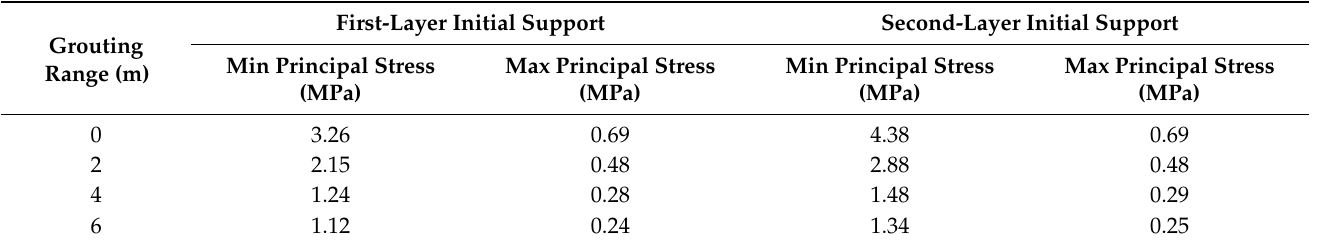
Table 3. Minimum and maximum principal stress of initial support with different grouting ranges.